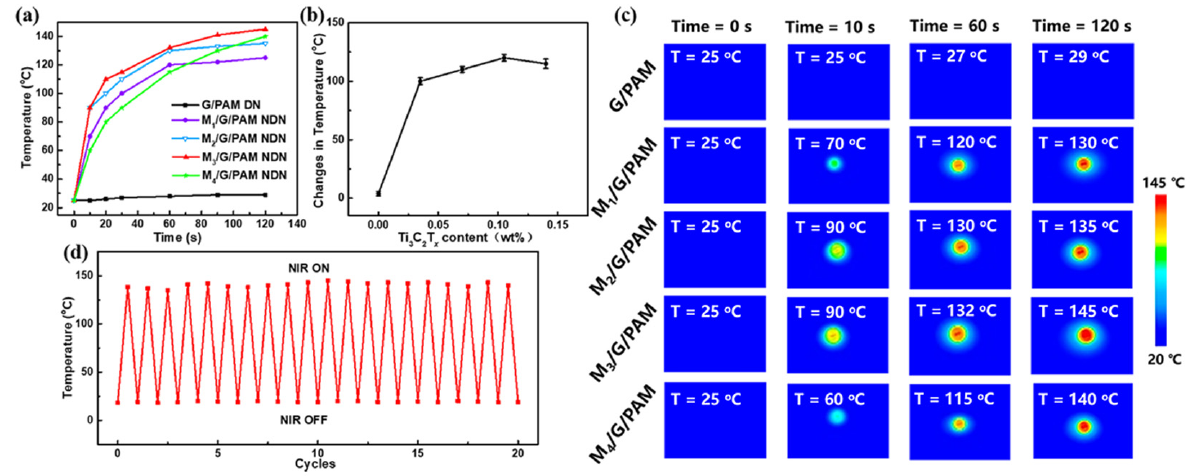
Figure 7. ( a ) Temperature of hydrogels with different Ti 3 C 2 T x contents upon 808 nm NIR laser irradiation (56.6 W cm − 2 ); ( b ) comparison of temperature change in the hydrogels with different contents of Ti 3 C 2 T x after 120 s NIR laser irradiation (56.6 W cm − 2 ); ( c ) the real-time infrared thermal images of different hydrogels; stability of M 3 /G/PAM hydrogel: ( d ) 20 cycles photothermal stability under repeated laser on–off of 808 nm NIR laser irradiation (56.6 W cm − 2 ).